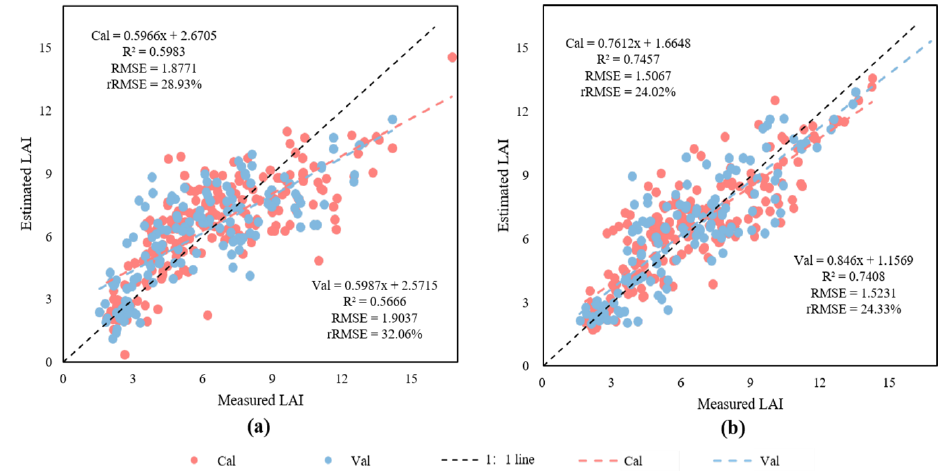
Figure 10. Linear results of training sets (Cal) and validation sets (Val) measured and predicted values based on vegetation indices model: ( a ) MSR-SNV and ( b ) ELM-SNV.